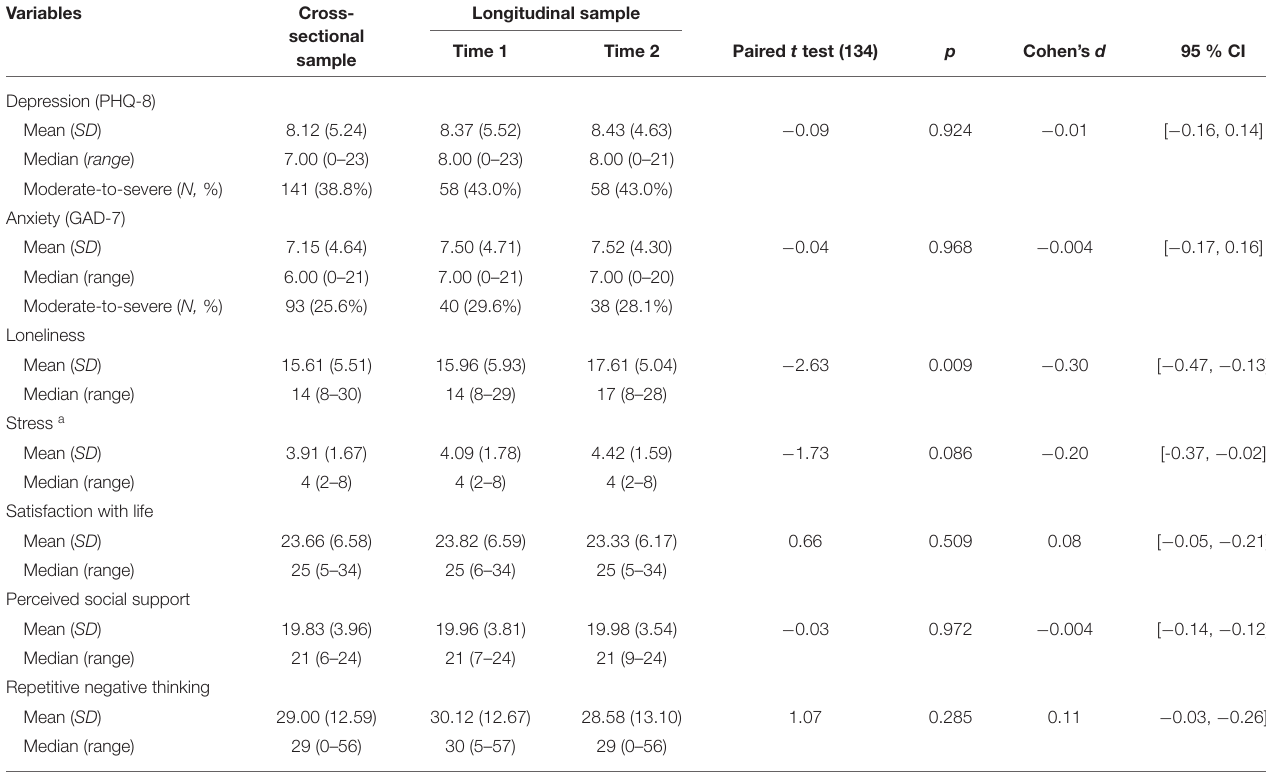
TABLE 3 | Primary outcomes and additional psychological variables during the COVID-19 pandemic.